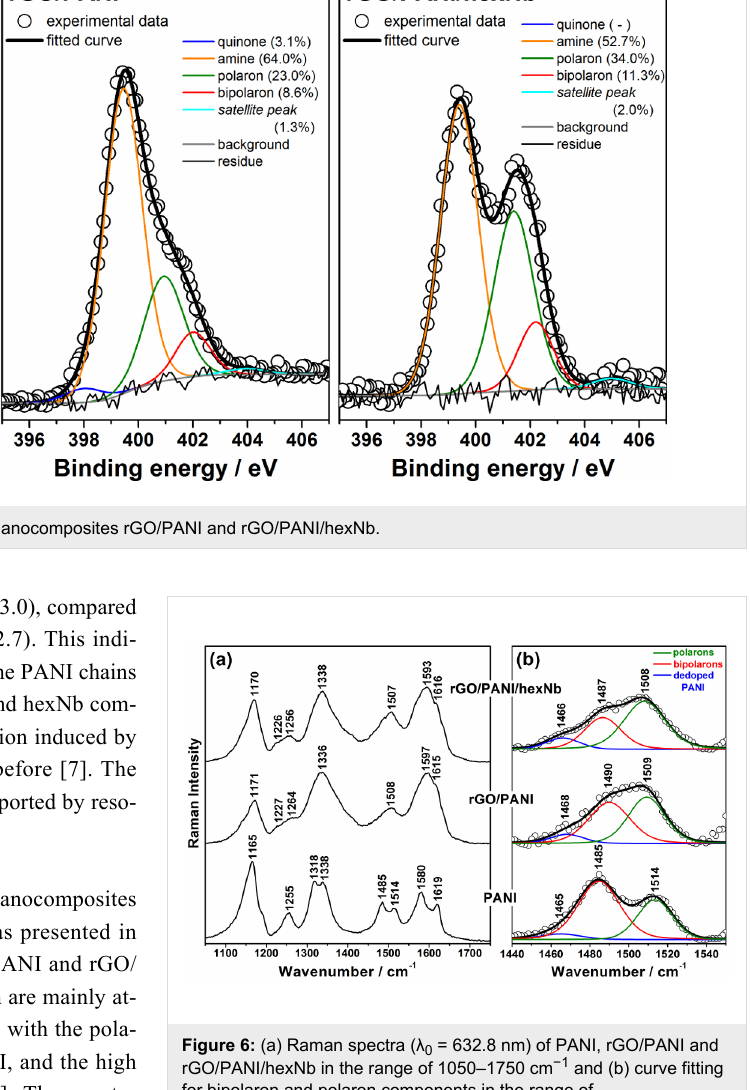
Figure 6: (a) Raman spectra ( λ 0 = 632.8 nm) of PANI, rGO/PANI and rGO/PANI/hexNb in the range of 1050–1750 cm − 1 and (b) curve fitting for bipolaron and polaron components in the range of 1440–1550 cm − 1